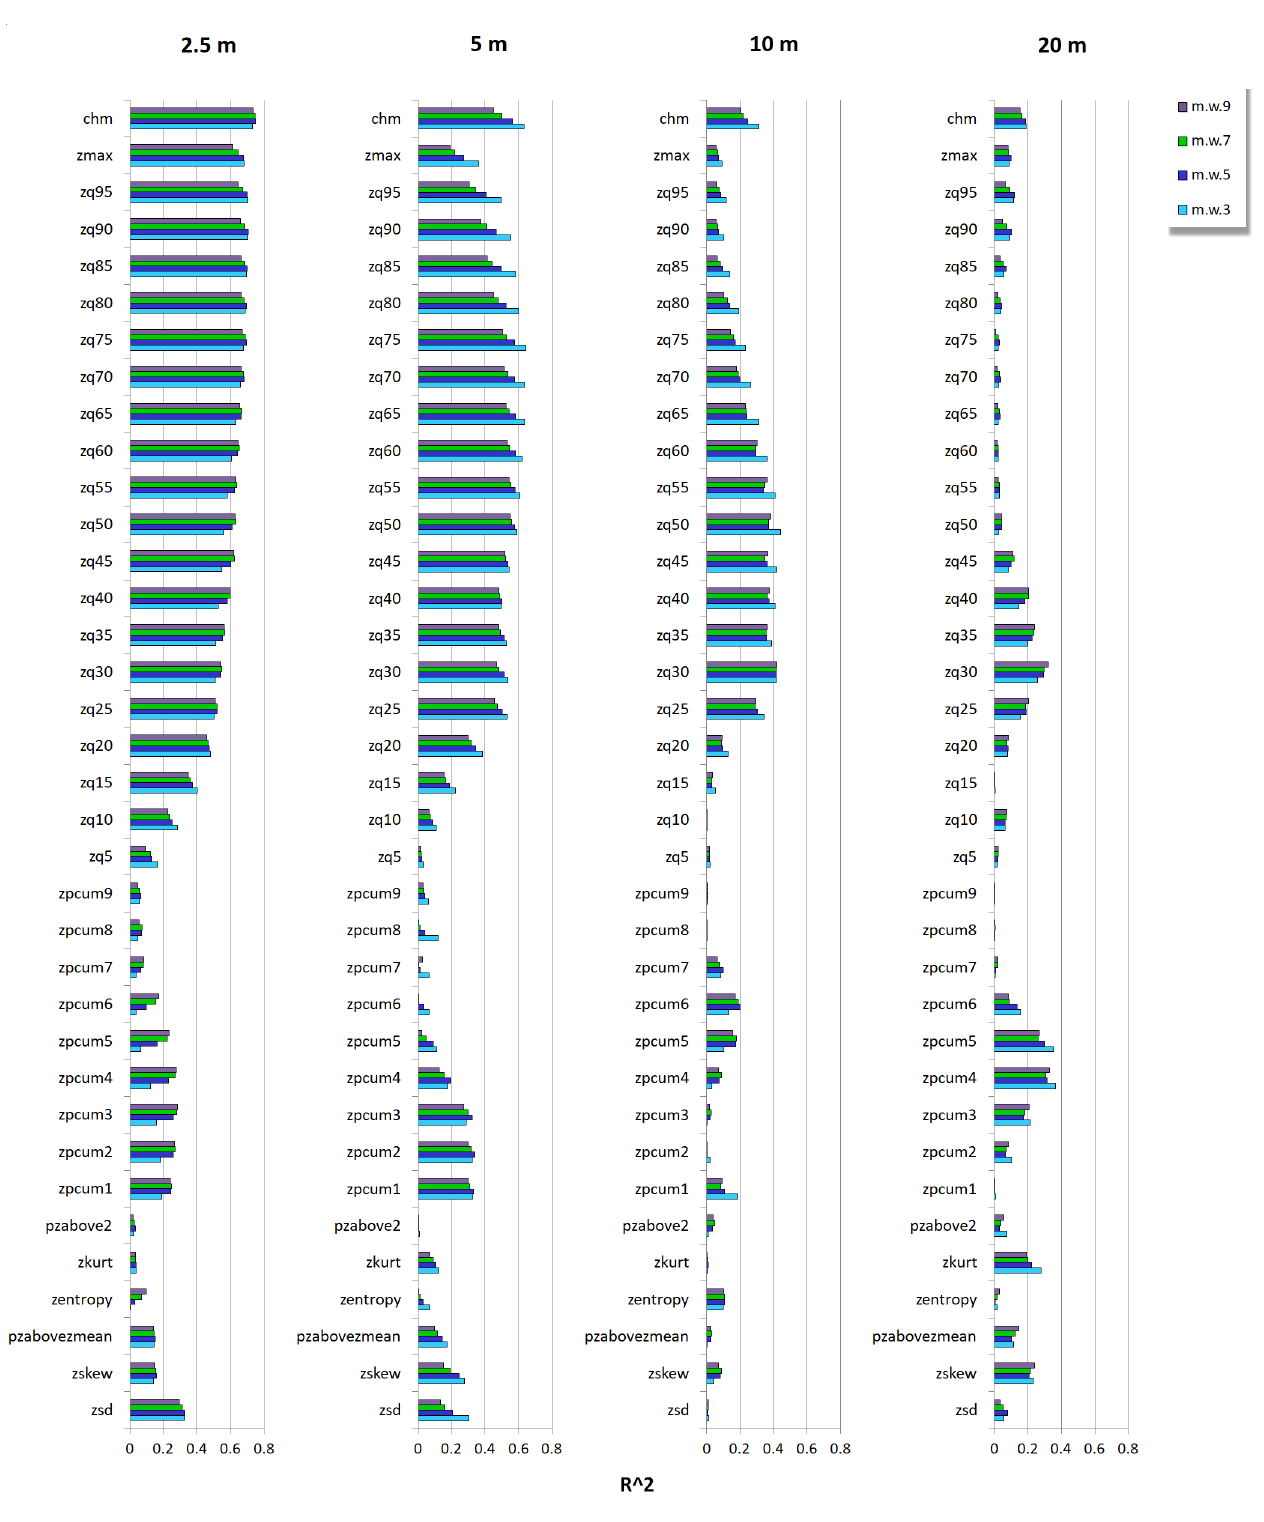
Figure 3. Performance of each LiDAR-based metric to describe tree species diversity. In particular, the histograms show the R 2 values relative to the linear regression between Shannon’s H (derived from field data) and the mean of the Rao’s Q matrices of each LiDAR-based metric and for each